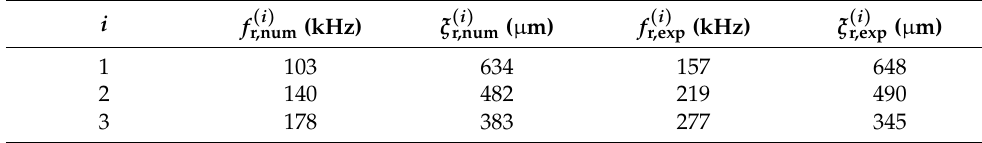
( i ) ( i ) Table 4. Resonance frequency ( f r,num and f r,exp ) and resonance positions ( ξ MEMS device based on the experimental and numerical results. Although the maximum deviation ( i ) ( i ) between f r,num and f r,exp is 56.4%, the maximum deviation between ξ oscillation modes are predictable for the optimization of the electrode positions.